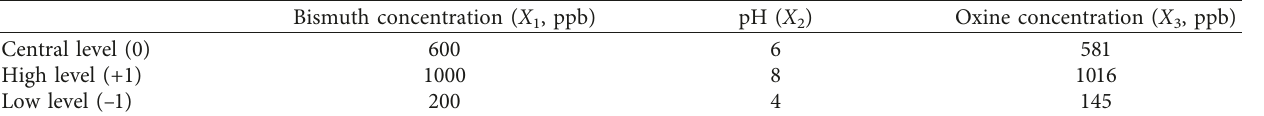
Table 1: Factors in BBD and their